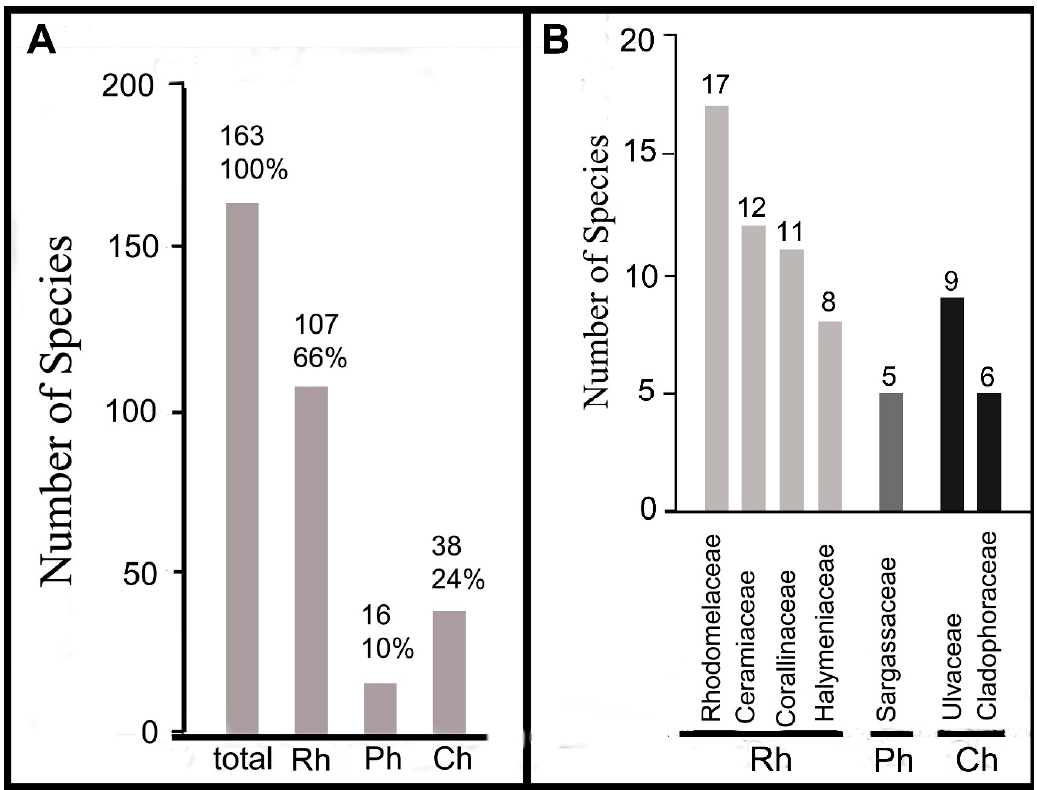
Figure 5. Species diversity and taxonomic composition of new findings of seaweeds along coast of the Tomioka Peninsula in 2012 − 2017. ( A ) Absolute and relative species numbers of different taxonomic groups (Rh, Ph, Ch). ( B ) Species numbers in dominant families.